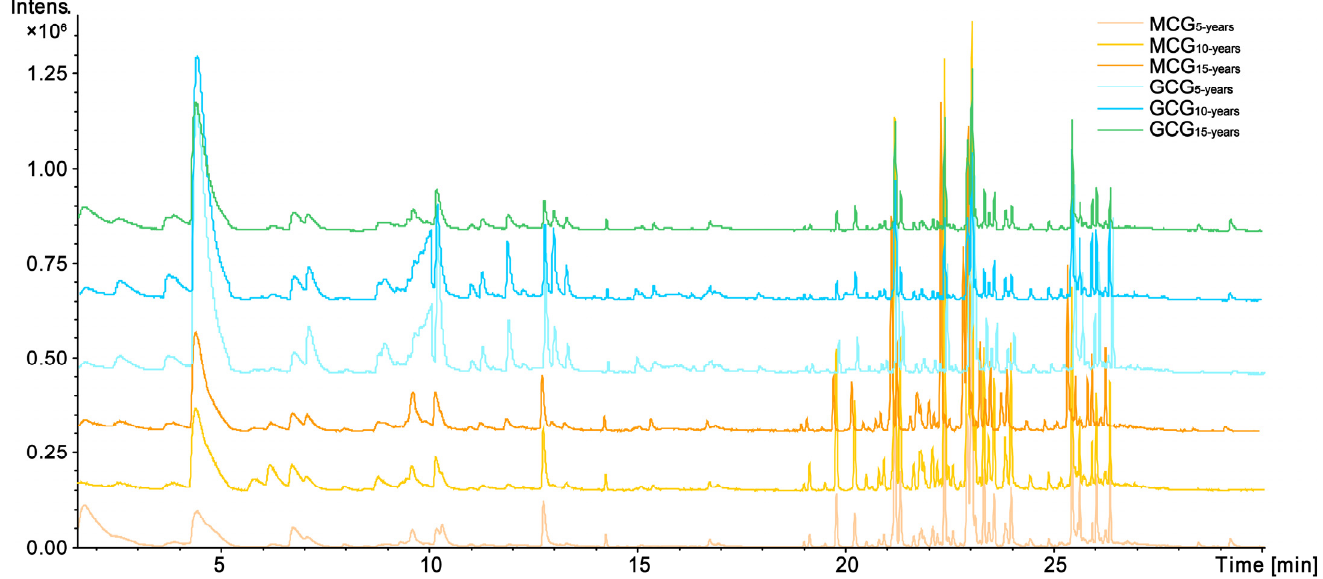
Figure 1. The based peak intensity (BPI) chromatograms of Garden-Cultivated Ginseng (GCG) and Mountain-Cultivated Ginseng (MCG) with 5-,10-,15-growth years by headspace solid-phase microextraction gas chromatography mass spectrometry (HS-SPME-GC-MS).